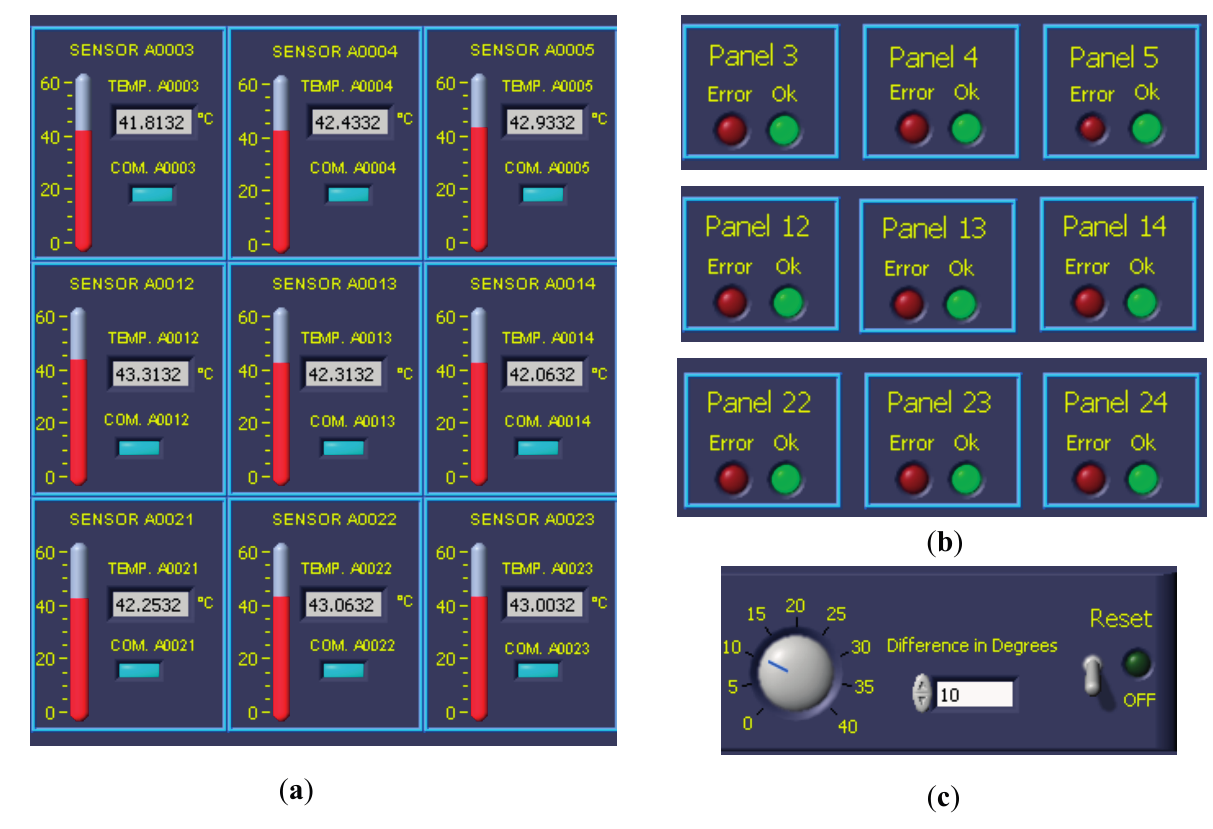
Figure 11. Details (zoom) of Figures 9 and 10. ( a ) Temperature Modules 3, 4 and 5; 12, 13 and 14; 21, 22 and 23; ( b ) Comparison between adjacent panels: 4 with 3 and 5; 13 with 12 and 14; 23 with 21 and 24; ( c ) Setting the allowed temperature threshold between adjacent